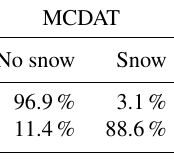
Table 2. Confusion matrix for snow cover derived from Landsat 7, Landsat 8 and Sentinel 2 compared to the Modis Aqua and Terra daily snow product